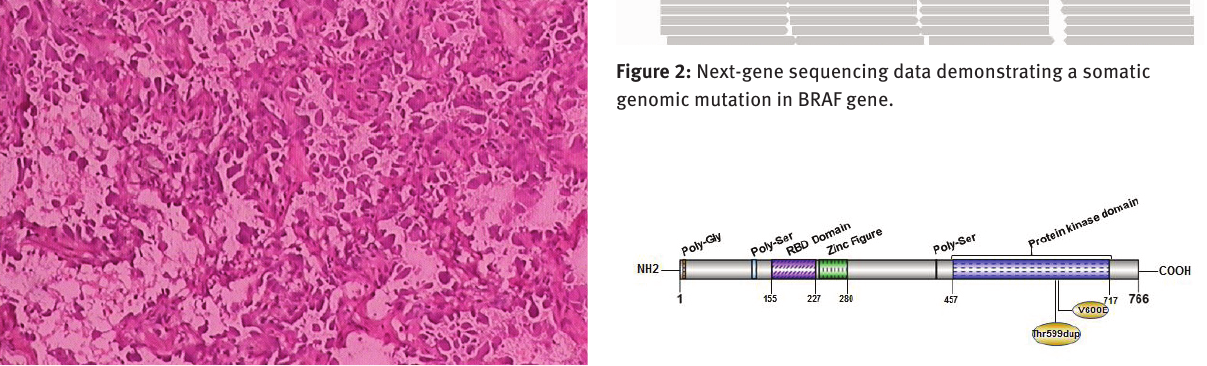
Figure 3: Schematic representation of the BRAF Thr599dup gene mutation.